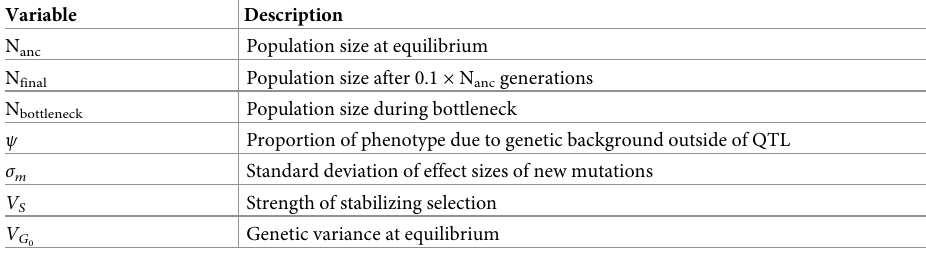
Table 1. Parameters and